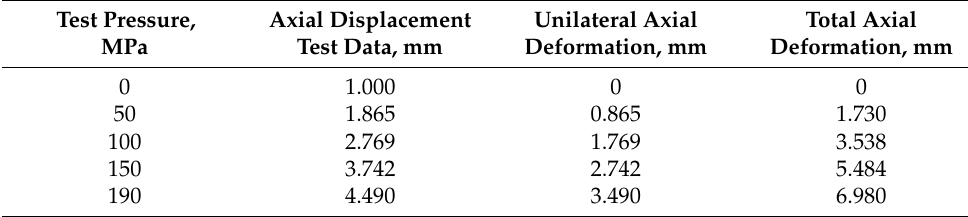
Figure 10. Pressure system for testing the rock cabin. Table 5. Axial deformation of the rock cabin. Table 5. Axial deformation of the rock